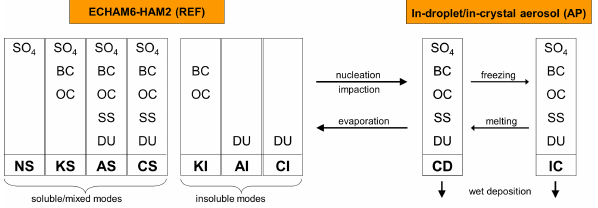
Figure 3. Processes and tracers used in the aerosol processing scheme. New tracers for aerosol particles in cloud droplets (CD) and ice crystals (IC) are added to the tracers for the soluble/mixed modes of HAM2 (nucleation, NS; Aitken, KS; accumulation, AS; coarse, CS) and insoluble modes (Aitken, KI; accumulation, AI; coarse, CI)